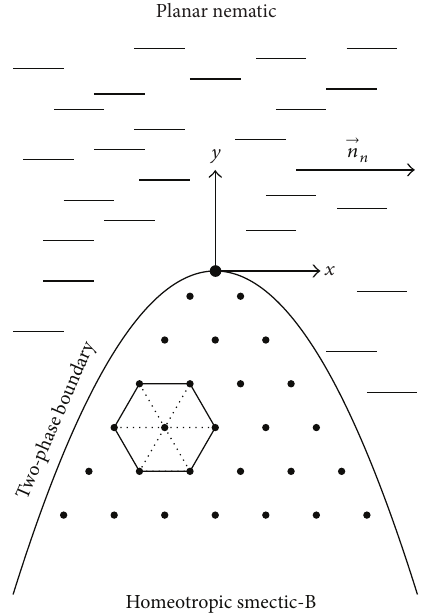
Figure 1: Scheme of the liquid crystal system setup considered